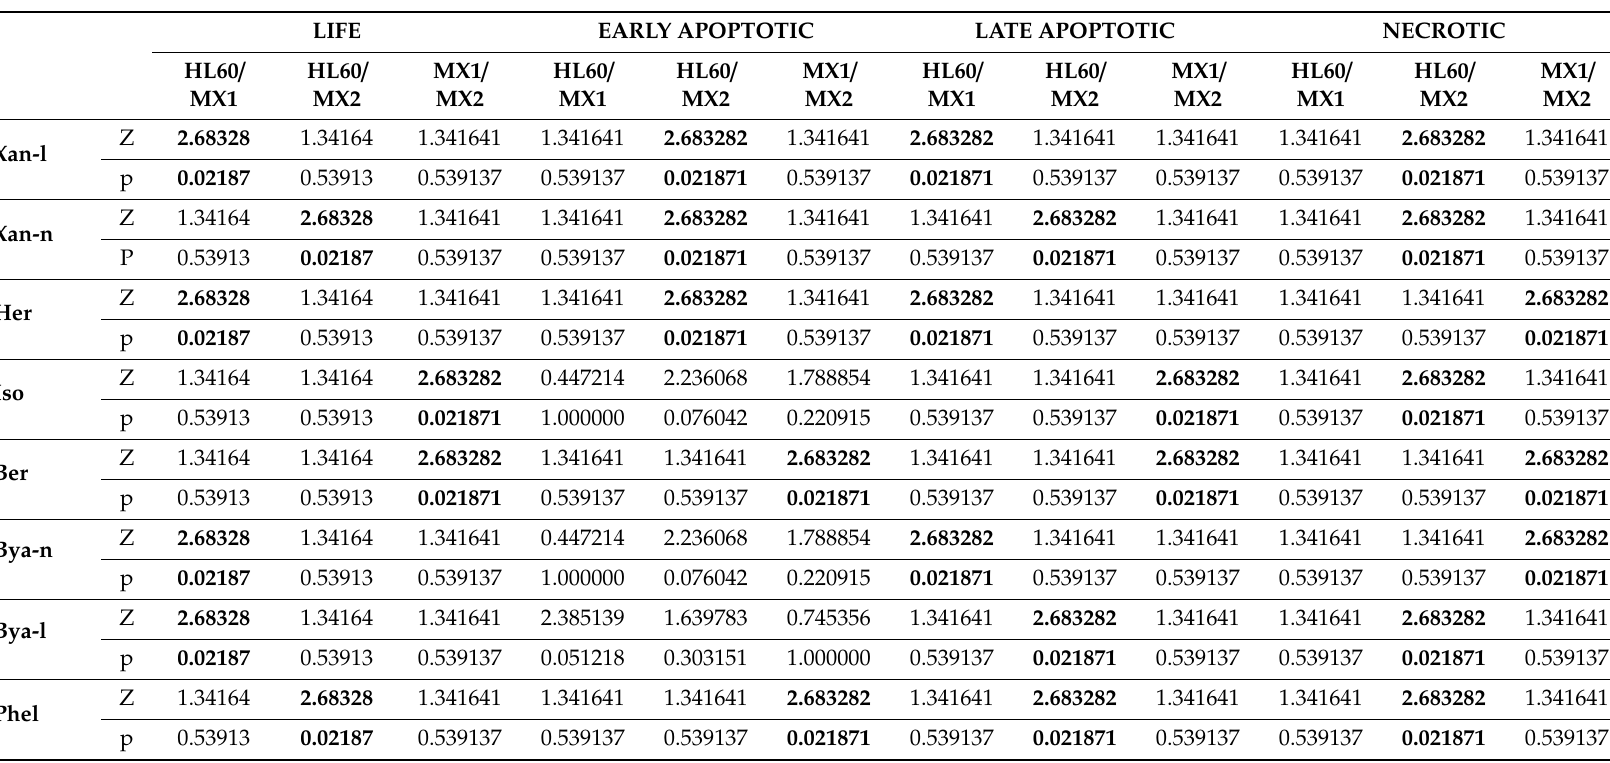
Table 3. Statistically significant di ff erences between the lines exposed to the tested furanocoumarin without the presence of mitoxantrone. Results of Kruskal–Wallis test: “Z” values for multiple comparisons, “ p ” values for multiple comparisons. The level of significance was set at p <